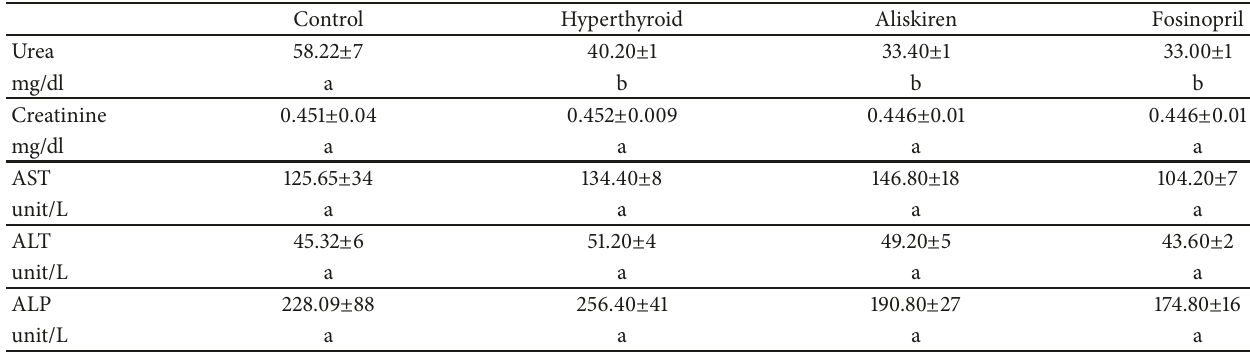
Different letters indicate significance differences at P < 0.05. Table 6: Blood biochemistry tests in control, hyperthyroid, Aliskiren, and Fosinopril groups.